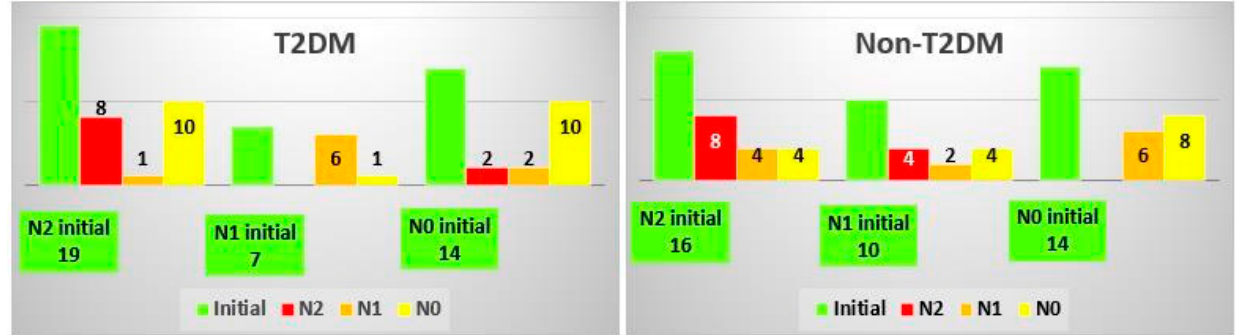
Figure 5. Changes in the NashTest class after treatment in the T2DM and non-TDM2 groups.